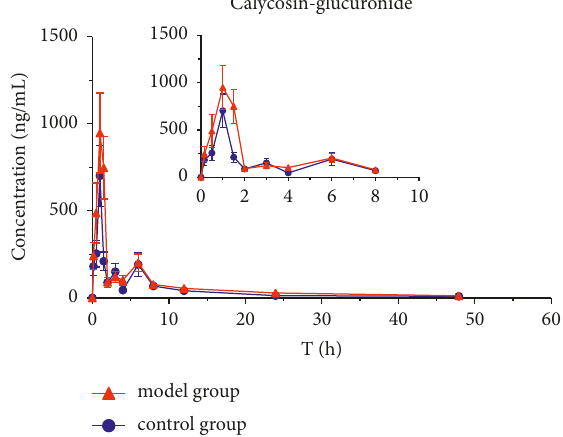
Figure 8: Concentration-time profiles of calycosin-glucoside after HQD administration ( x ± SD, n �